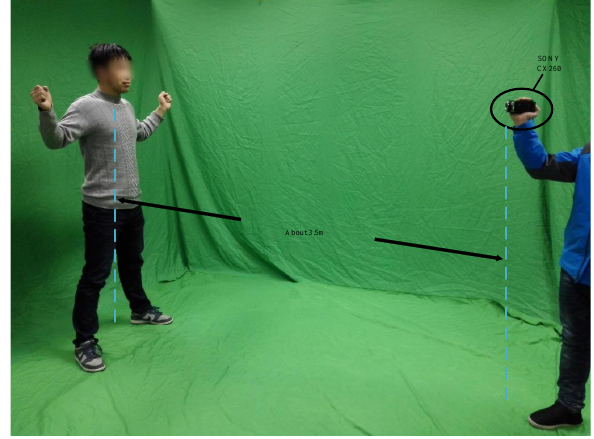
Figure 9. Our setup consists of a common camera, which can record the whole body of the people at an appropriate